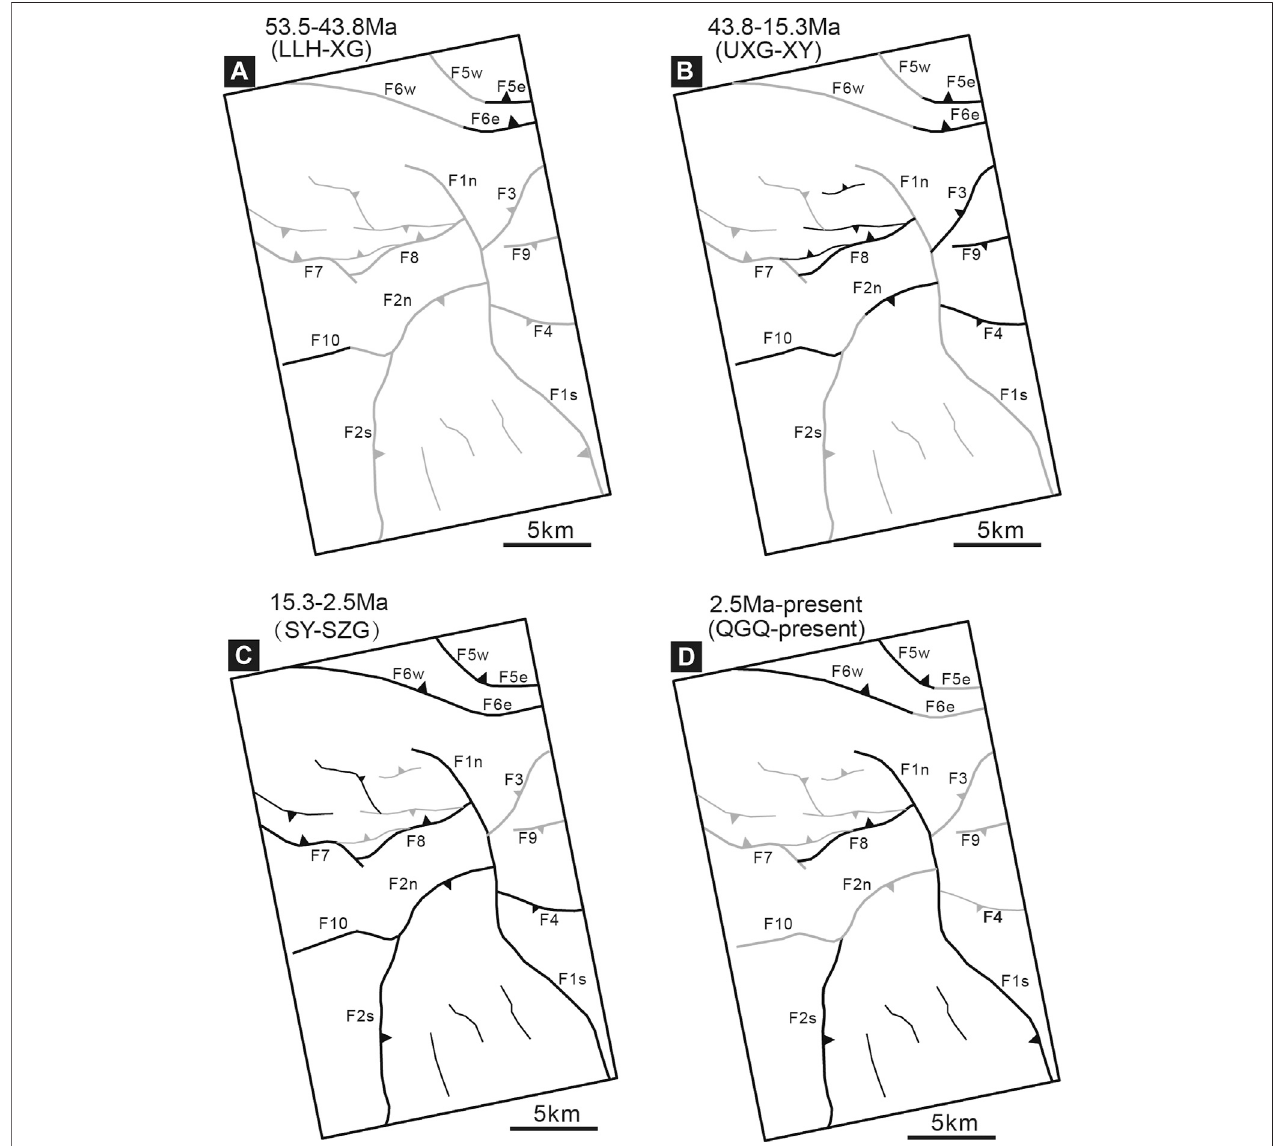
FIGURE 6 | Summary of temporal development of the basement-involved faults within the study area. Black solid lines are active faults during corresponding period; whereas gray lines represent inactive ones.